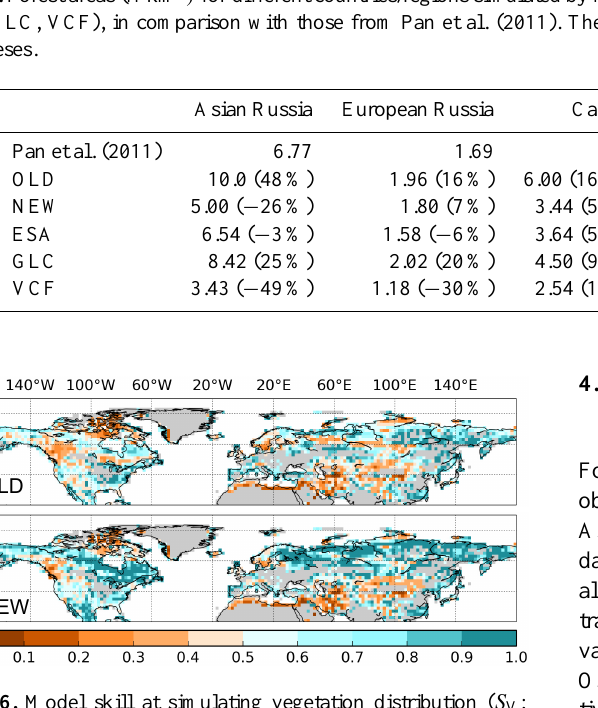
Figure 6. Model skill at simulating vegetation distribution ( S V ; Eq. 10) for OLD and NEW. S V ranges from 0 to 1, with higher values representing better model performances, integrating obser- vational uncertainty. Three kinds of grid cells are masked out (in gray): (1) the grid cells where S V > 1 for both models, indicating that the observational data have too large uncertainties to be quali- fied for model evaluation (13% of the total land points for the stud- ied region); (2) the grid cells where all models and data sets have 100% bare ground in the Sahara and Greenland (10%); and (3) the grid cells where crop fraction is higher than 0.5 (8%).